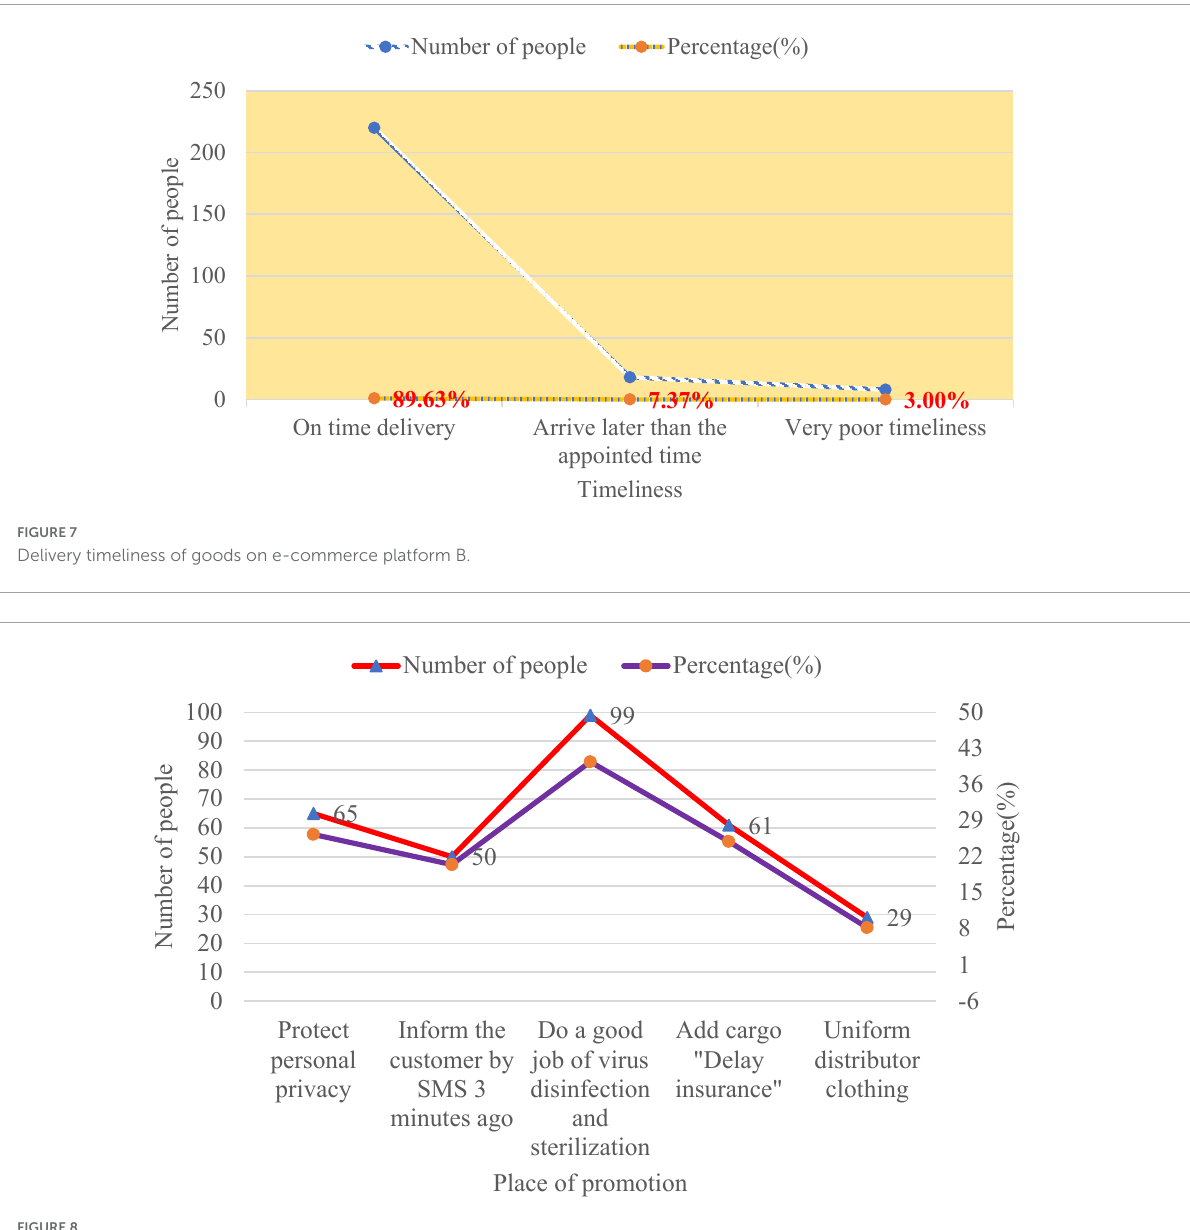
FIGURE8 The distribution aspects of e-commerce platform B that need to be